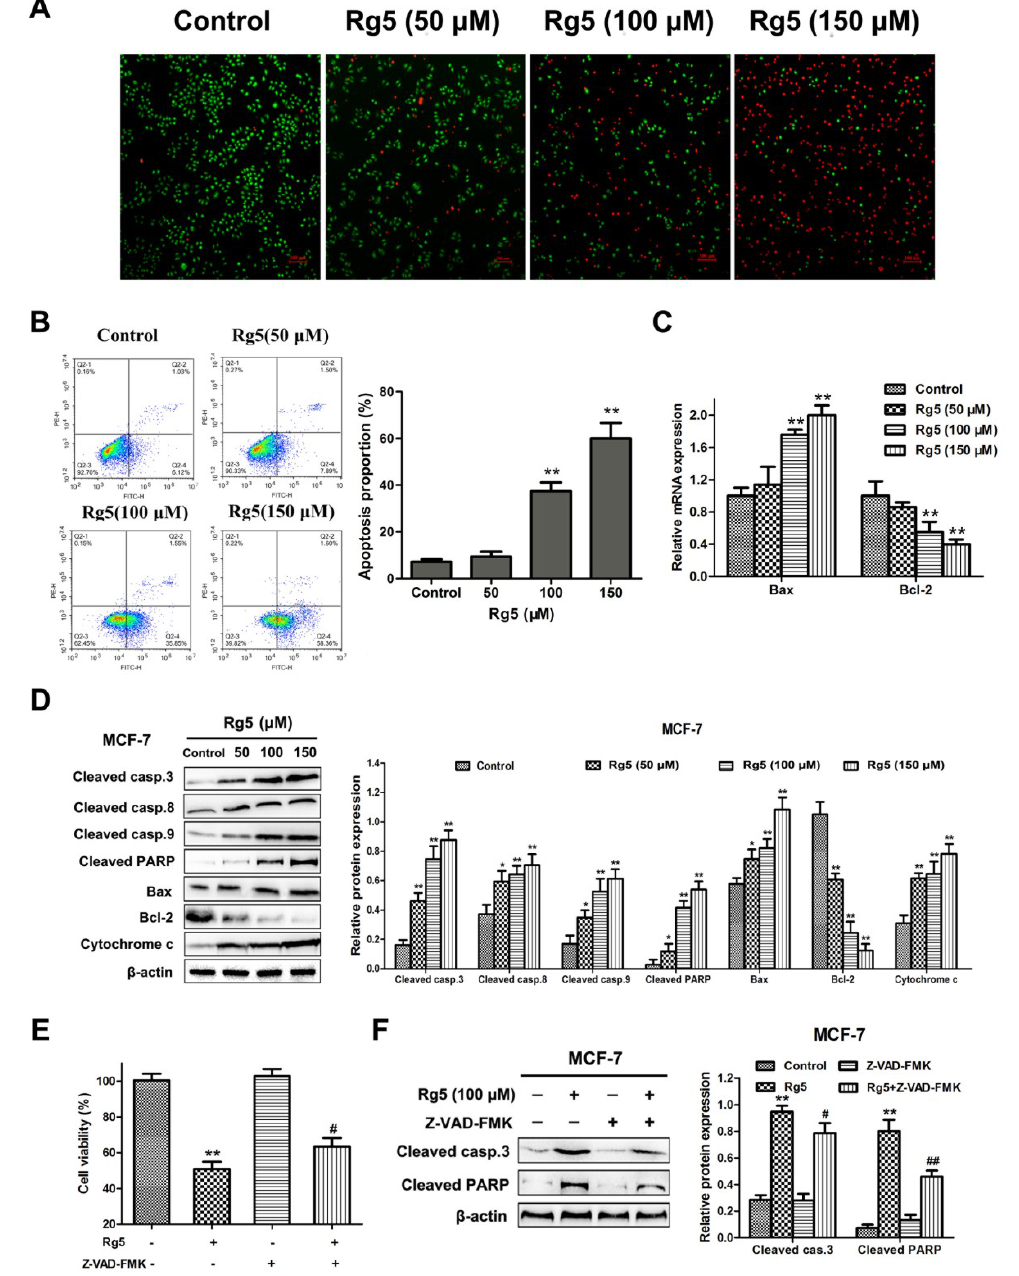
Figure 4. Rg5 triggers apoptosis in human breast cancer cells. ( A ) AO/EB staining was performed to assess apoptosis-induced morphological variation via fluorescence microscopy. Scale bars = 100 μm. ( B−D ) MCF-7 cells were exposed to Rg5 at different concentrations for 24 h. ( B ) Cells were detected by flow cytometry after Annexin V-FITC/PI staining. The chart illustrates the proportion of apoptotic cells. ( C ) The relative mRNA expression levels of Bax and Bcl-2 were determined using real-time qRT-PCR. ( D ) The levels of apoptosis-related proteins were analyzed via Western blot assay. ( E, F ) MCF-7 cells were exposed to Rg5 (100 μM) in the presence of Z-VAD-FMK (100 μM). ( E ) The MTT assay was used to detect cell viability. ( F ) The expression levels of cleaved caspase-3 and cleaved PARP were determined via Western blot analysis. * P < 0.05 and ** P < 0.01 as compared with the control group. # P < 0.05 and ## P < 0.01 as compared with Rg5-treated cells. 3.4. Rg5 Induces Apoptosis via the Mitochondria-Mediated Pathway